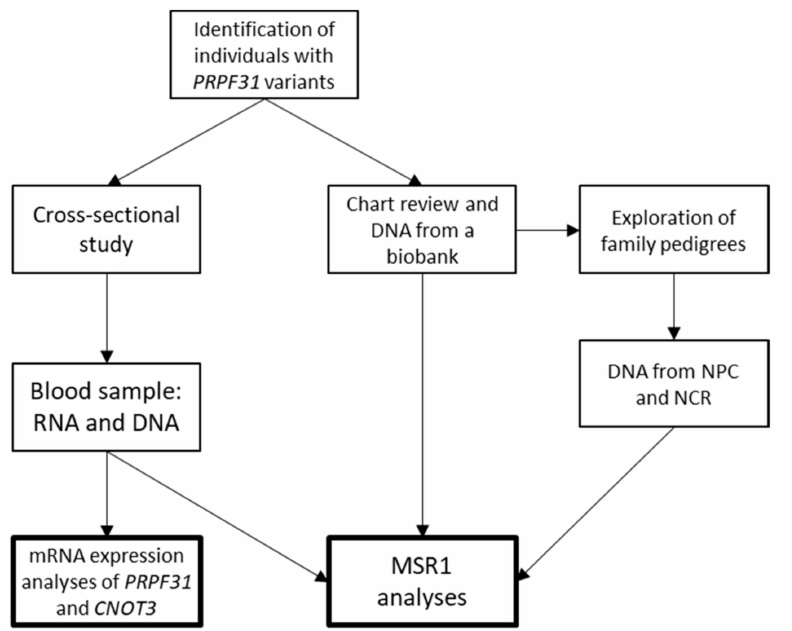
Figure 1. Illustration of the study workflow. mRNA expression analyses were dependent on whether the individual had a blood sample collected in a PAX tube. NPC: non-penetrant carrier. NCR: non-carrier